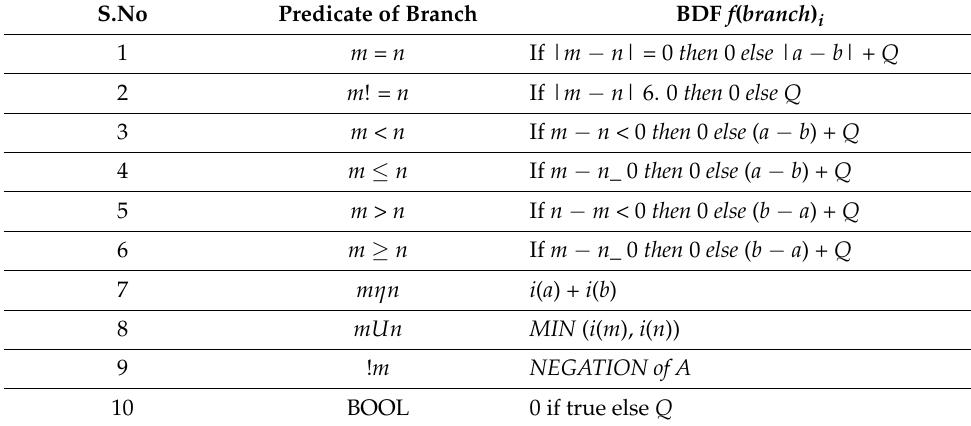
Table 1. BDF for branch